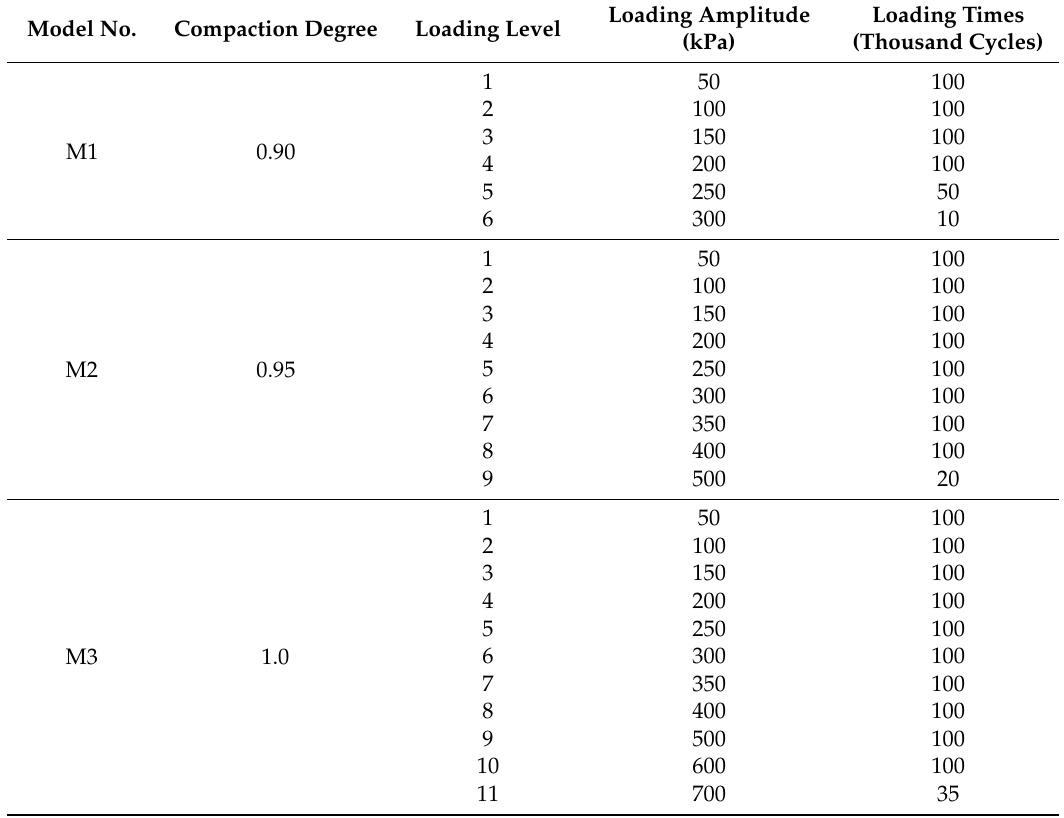
Table 2. Amplitude of cyclic loads and loading times for three